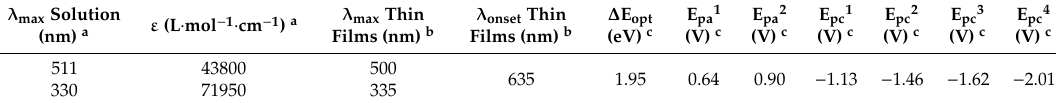
Table 1. Optical and electrochemical data of BDT-C 60 . UV-visible spectra recorded in a) chloroform and b) on glass; c) cyclic voltammetry performed on a 0.5 mM solution of BDT-C 60 in 0.1 M